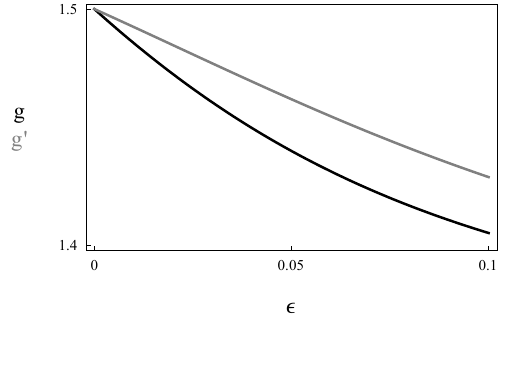
Figure 3. Steady state growth factor of the population without suicide ( g ) and with ( g (cid:48) ), as a function of (cid:15) and letting α = 1 . 5 and β = 1 . 2